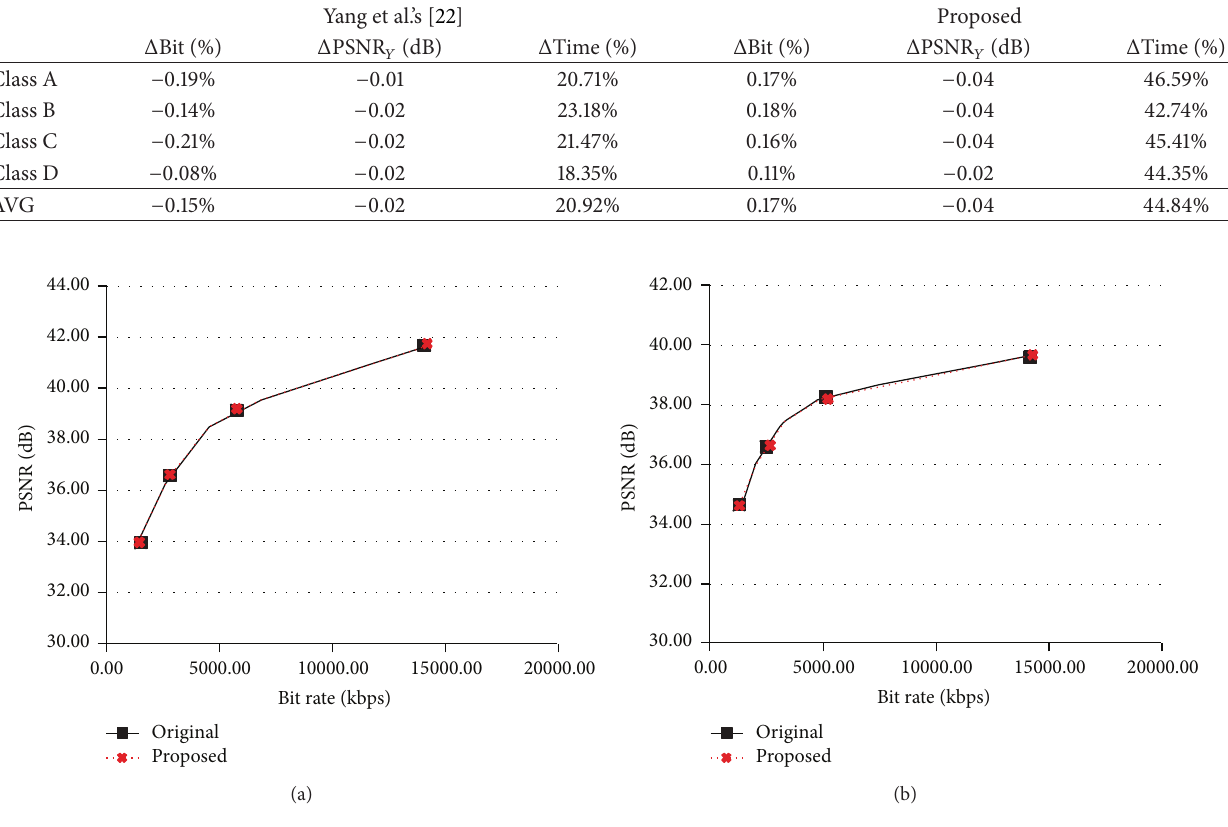
Figure 5: Rate-distortion (RD) curves for Class A: (a) Traffic and (b) BasketballDrive sequences.